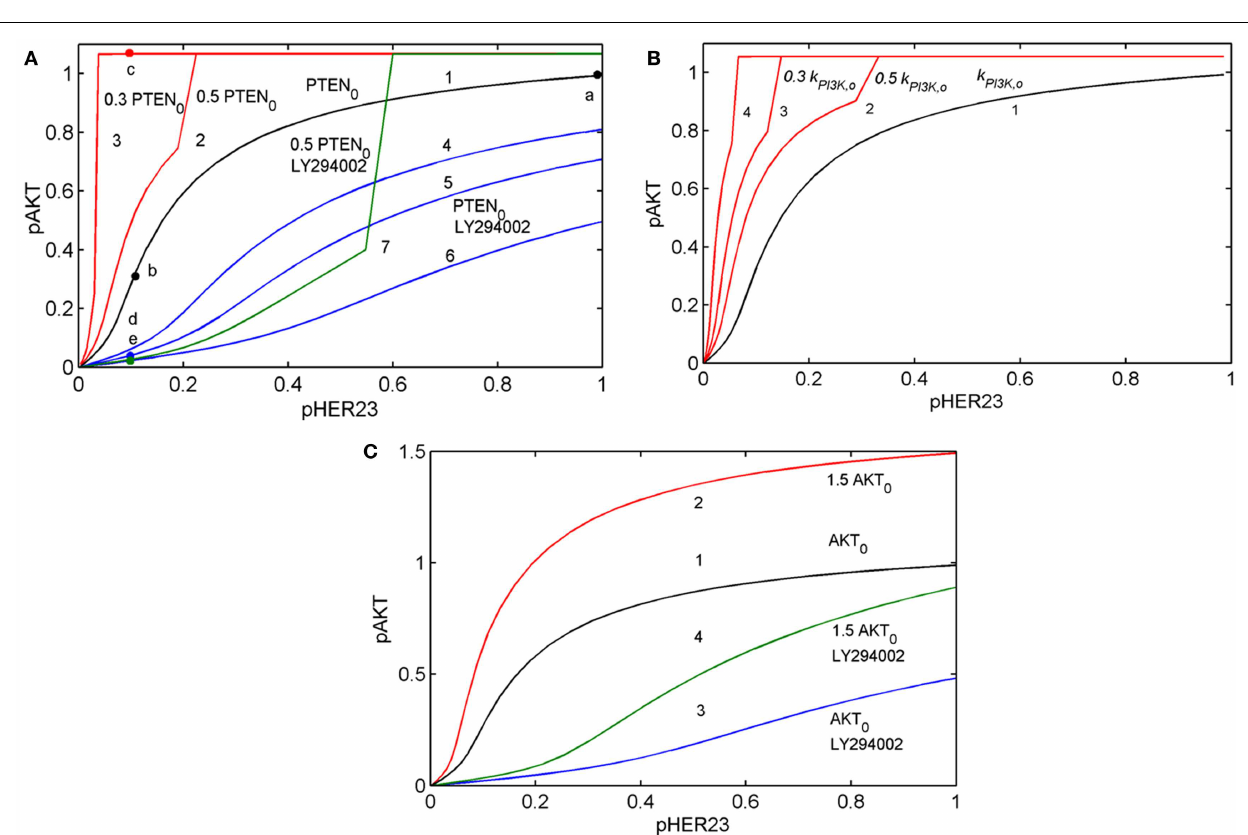
FIGURE 3 | Input/output response of the PI3K/PTEN/AKT pathway R AKT to p HER23 input signal and its modification by activation mutations of PTEN, PI3K, andAKT proteins and inhibition of PI3K by LY294002 inhibitor . (A) Modification of R AKT by a change of initial concentration of PTEN: response curve at the reference concentration of PTEN 0 = 40 µ M (line 1), 50% PTEN loss (line 2), 70% PTEN loss (line 3). Modification of R AKT by PI3K inhibition: 0.3 µ M LY294002 (line 4), 0.5 µ M LY294002 (line 5), and 1 µ M LY294002 (line 6). Modification of R AKT by 50% PTEN loss and inhibition of PI3K by 3 µ M LY294002 (line 7). Points a, b, c, d, and e correspond to